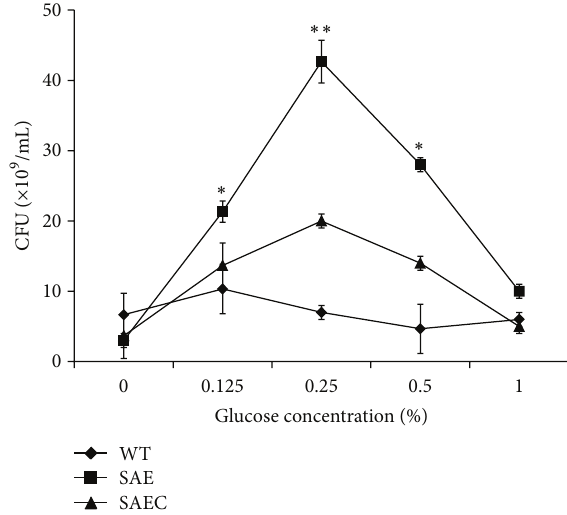
Figure 5: Viability of S. epidermidis 1457 in BM medium containing various concentrations of glucose. Overnight cultures of S. epider- midis were diluted 1 :200 in BM medium with or without 0.125%, 0.25%, 0.5%, and 1% (g/mL) glucose and incubated at 37 ∘ C for 24 h. Colony forming units (CFU) on TSA plates were further counted with serial dilutions of each sample plated on 6 agar